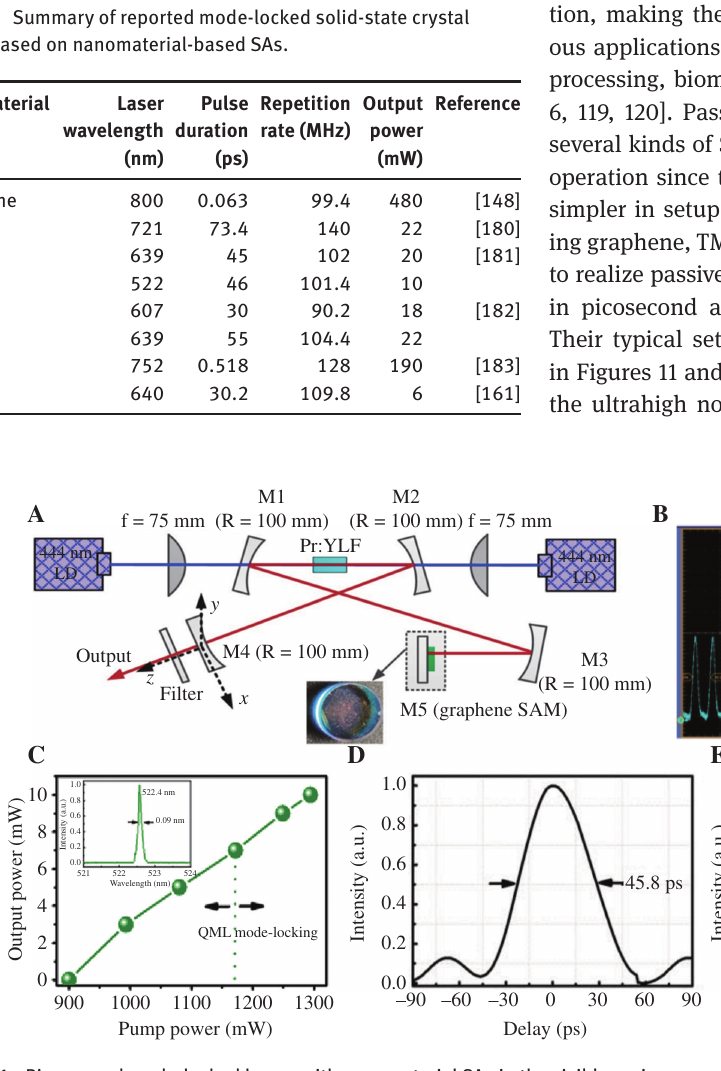
Figure 11: Picosecond mode-locked lasers with nanomaterial SAs in the visible region. (A) Schematic of frequently used “X”-type cavity. (B) Pulse trains based on NiO SA. (C) Average output power with TMDs, inset: the mode-locked spectrum of 522 nm. (D) A single pulse trace of a mode-locked laser with MoS . (E) Spectra of CW and mode-locked lasers with graphene; inset: 2 intensity distribution of the mode-locked vortex laser. (A) and (E) Adapted from Ref. [180], Copyright 2019, Chinese Laser Press. (B) Adapted from Ref. [161], Copyright 2018, Optical Society of America. (C) and (D) Reproduced from Ref. [182], Copyright 2017, Optical Society of